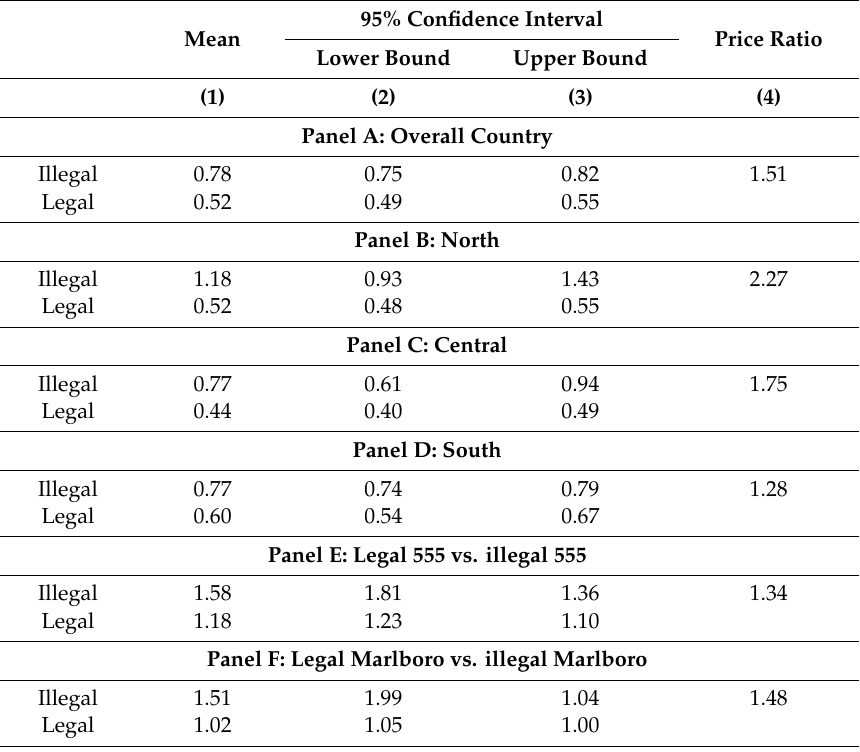
Table 4. Prices of illicit and licit cigarette packs